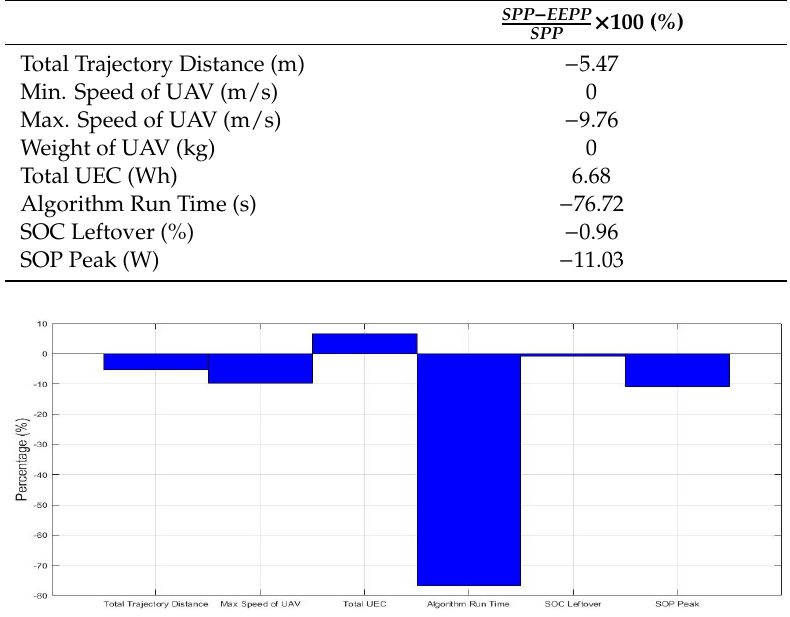
Figure 17. The comparison results in percentage (experiment).